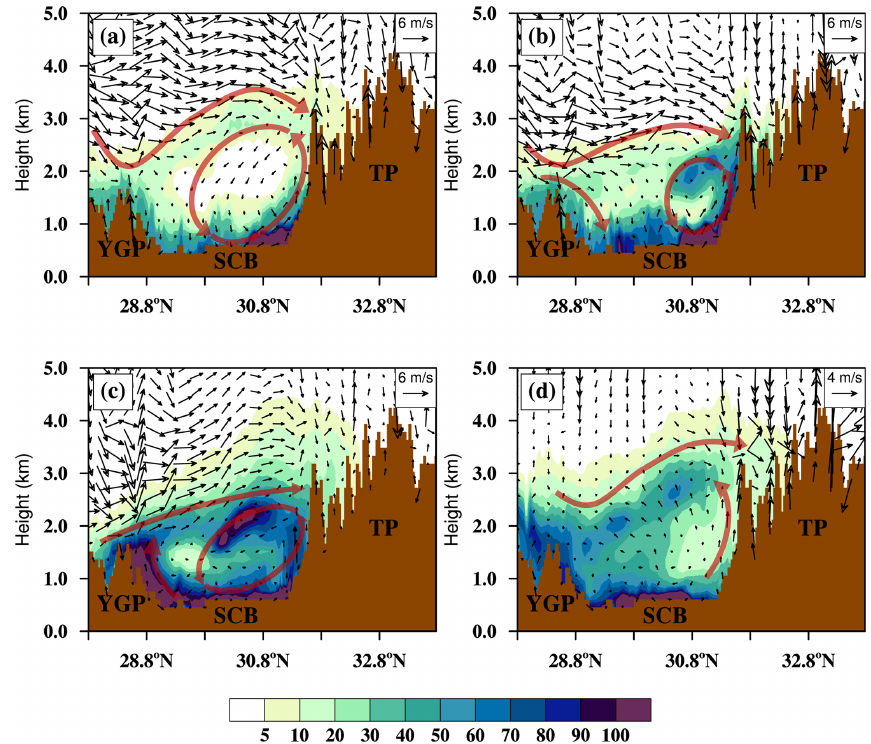
Figure 9. Same as Fig. 8, but for height–latitude cross sections of PM 2 . 5 concentrations and wind